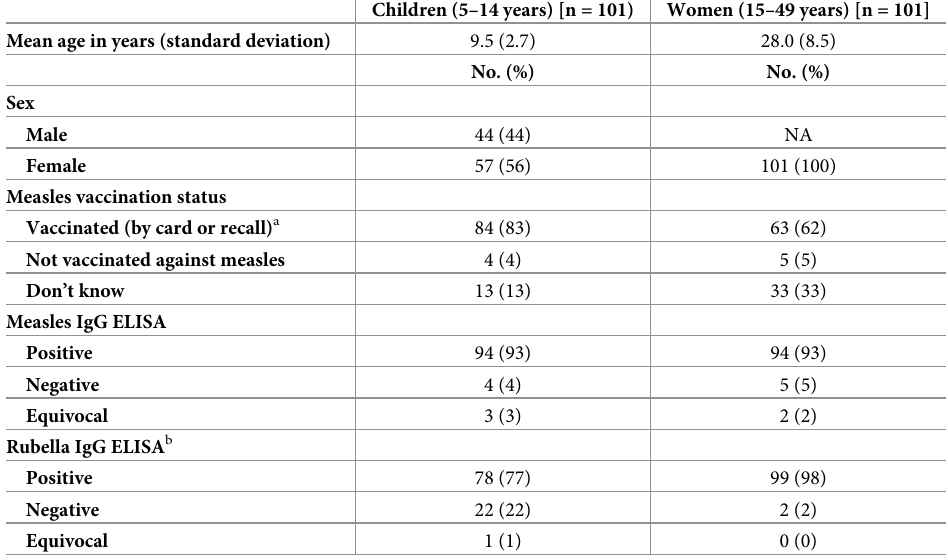
Table 2. Demographics, measles vaccination status, and measles and rubella IgG results for serosurvey—Biyela health district (one month after confirmed measles outbreak), Kinshasa province, DRC, 2017. Children (5–14 years) [n = 101) Mean age in years (standard